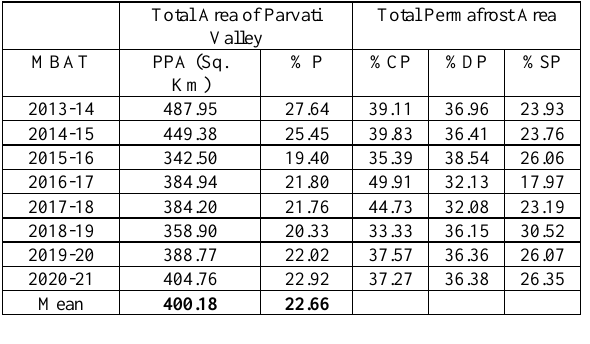
Table 1: The table summarizing the total (PPA) probable permafrost area (in Sq. Km and %) and the percentage of permafrost area in different categories (CP, DP, SP) using MBAT for each consecutive years starting from 2013 to 2021.